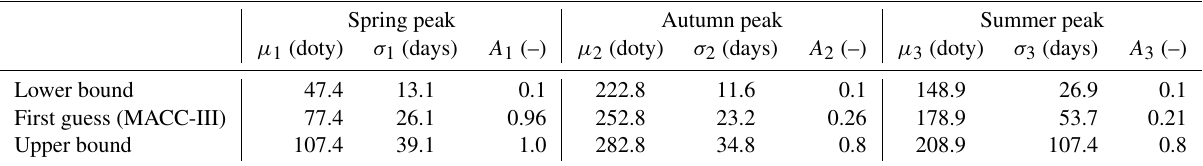
Table 1. Initial parameter guesses and parameter bounds used in the trimodal fit algorithm. Here, doty stands for day of the year. Spring peak Autumn peak Summer